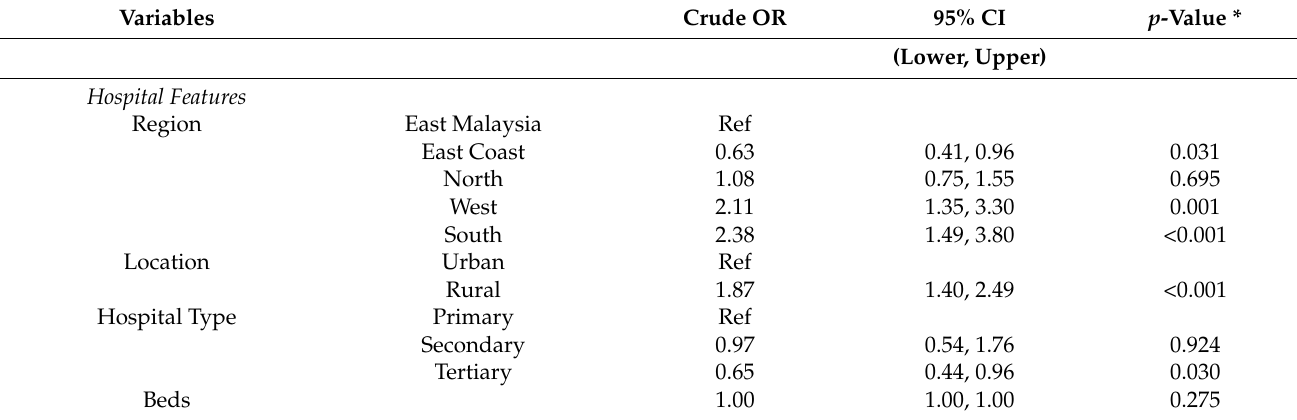
Table 3. Factors associated with patient dissatisfaction in univariate analysis ( n = 1825).